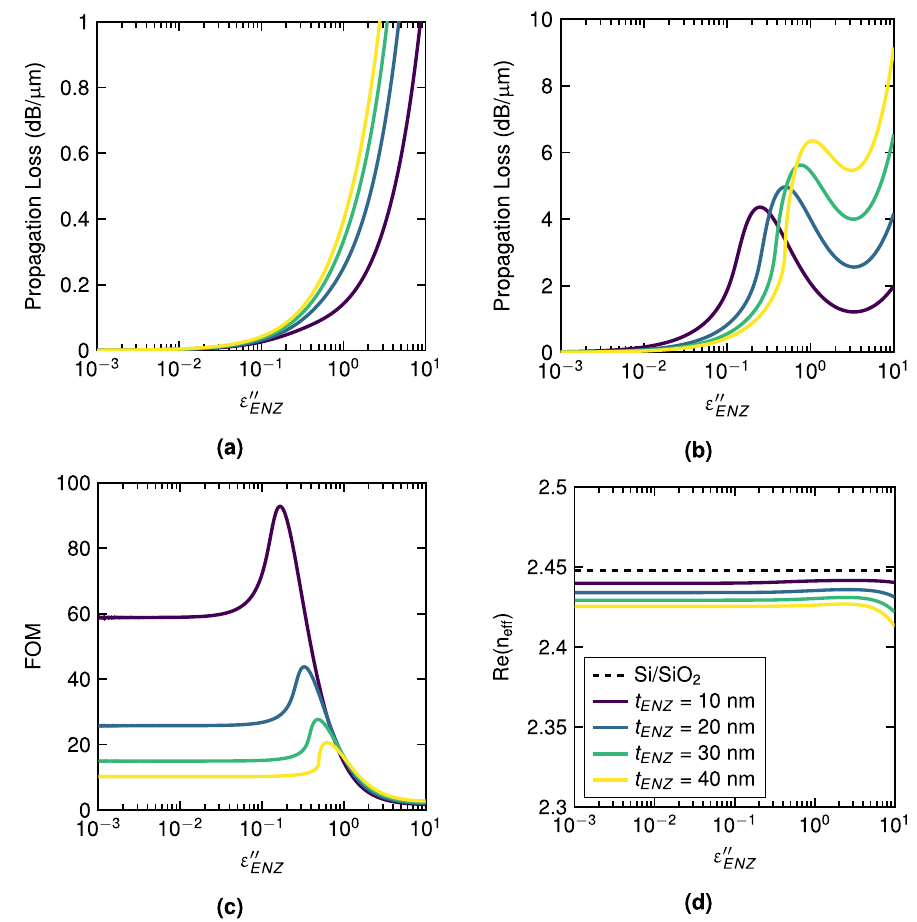
Figure 2. Derived parameters from the complex effective index of TE and TM modes of the hybrid ENZ/ Si waveguide as a function of the loss of the ENZ material, ε ′′ ENZ , and for different ENZ layer thickness, t ENZ . Propagation loss for ( a ) TE and ( b ) TM polarized modes. ( c ) Figure of merit. ( d ) Real part of the effective index for the TE mode. Values are given for (cid:31) = 1550 nm while imposing ε ′ ENZ = 0